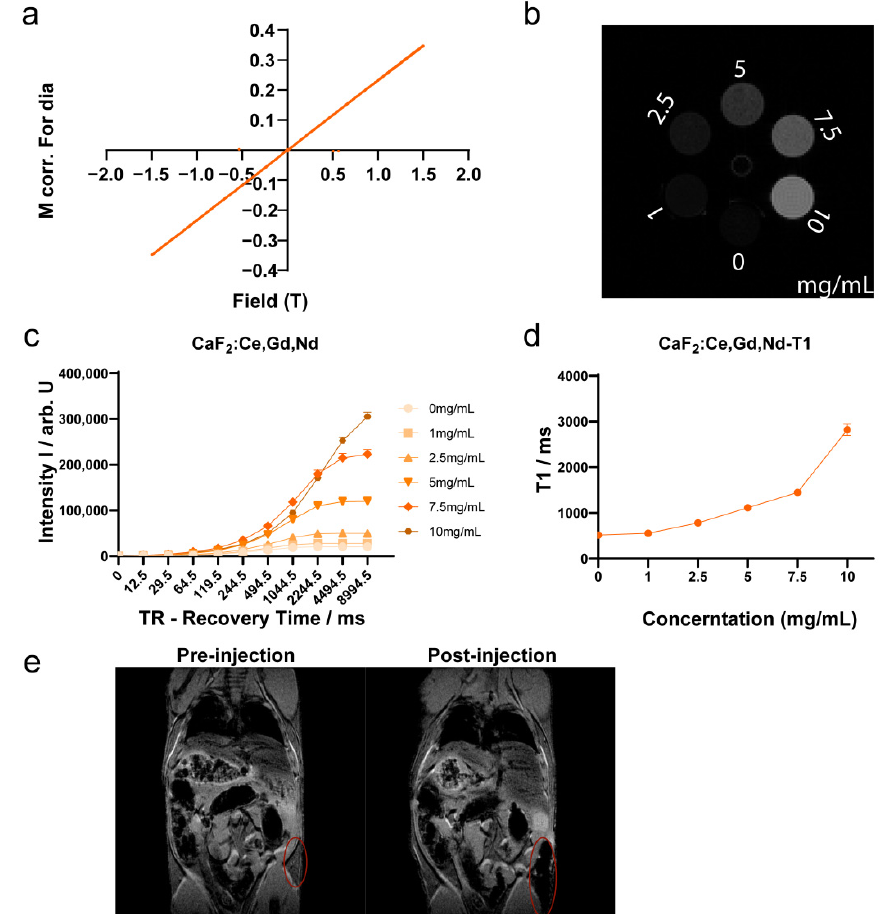
Figure 8. In vitro MRI performance of CaF 2 : Ce, Gd, Nd NPs. ( a ) Magnetic properties of CaF 2 : Ce, Gd, Nd NPs; ( b ) in vitro T1-weighted MRI of CaF 2 : Ce, Gd, Nd NPs at different concentrations in water containing 0.5 % agarose gel; ( c ) MRI signal intensity of CaF 2 : Ce, Gd, Nd NPs with increasing recovery time at different concentrations; ( d ) in vitro T1 relaxation rates of various CaF 2 : Ce, Gd, Nd NPs concentrations; ( e ) ex vivo MRI images of a mouse cadaver before and after subcutaneous injection of CaF 2 : Ce, Gd, Nd NPs (10 mg/mL).